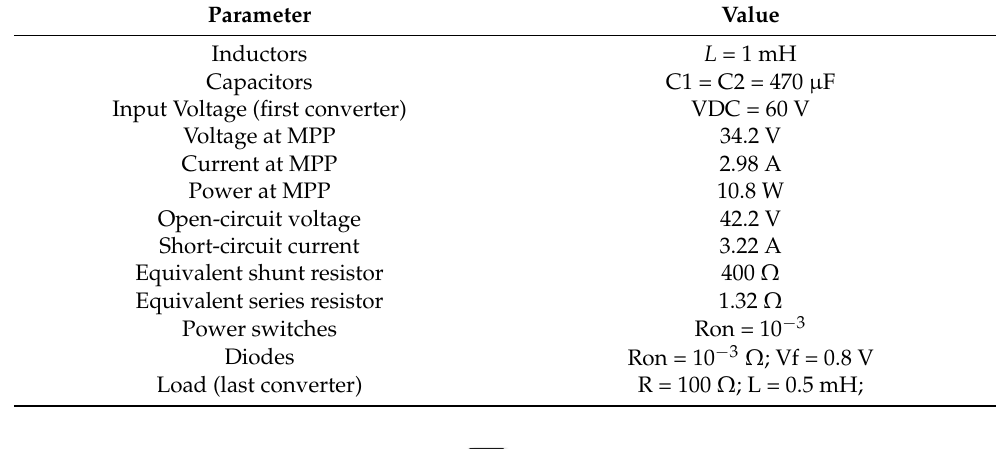
Table 3. Components selected for the DC–DC converters used in the simulations.